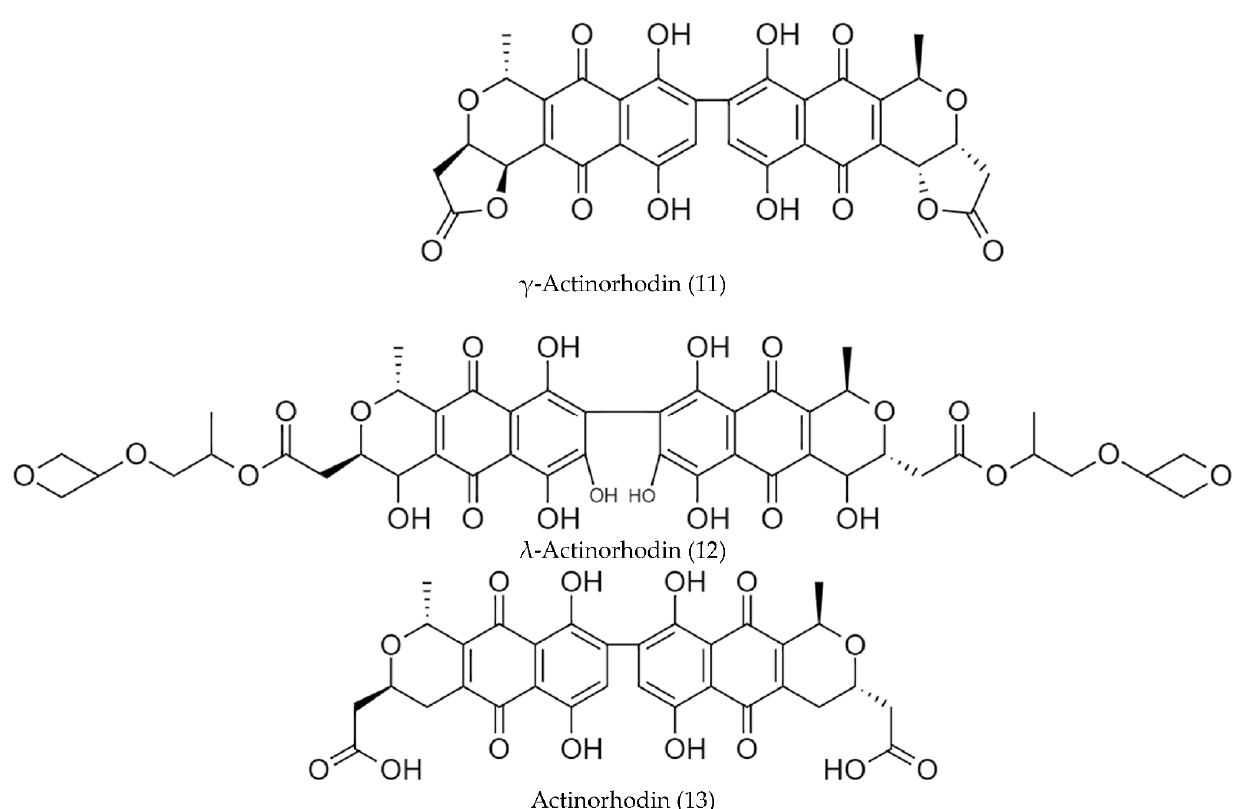
Figure 9. Chemical structures of actinorhodins.